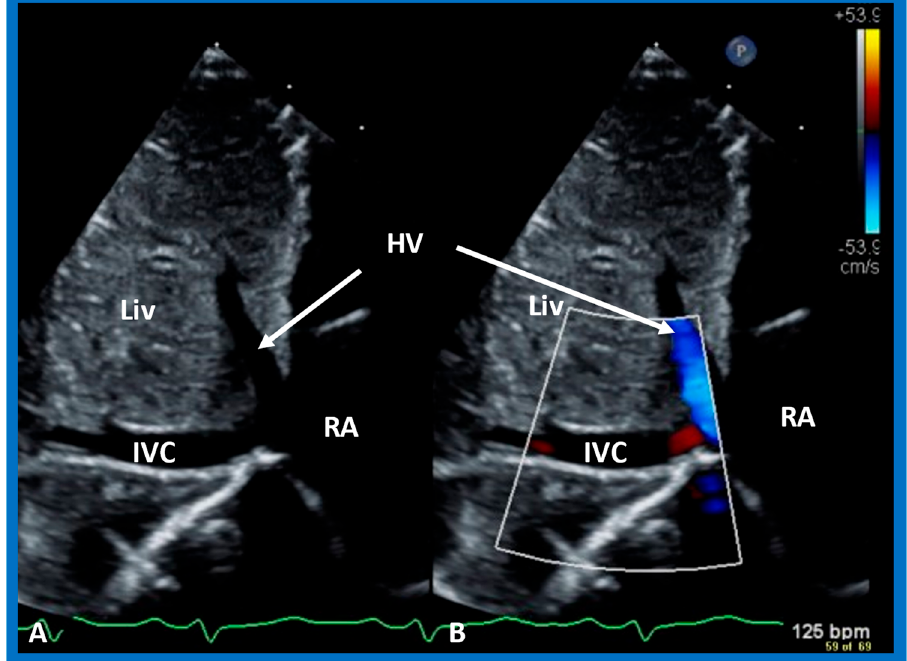
Figure 27. Subcostal echo images in two-dimensional ( A ) and color flow ( B ) illustrate the entrance of the inferior vena cava (IVC) into the right atrium (RA). HV, hepatic vein; Liv, liver.